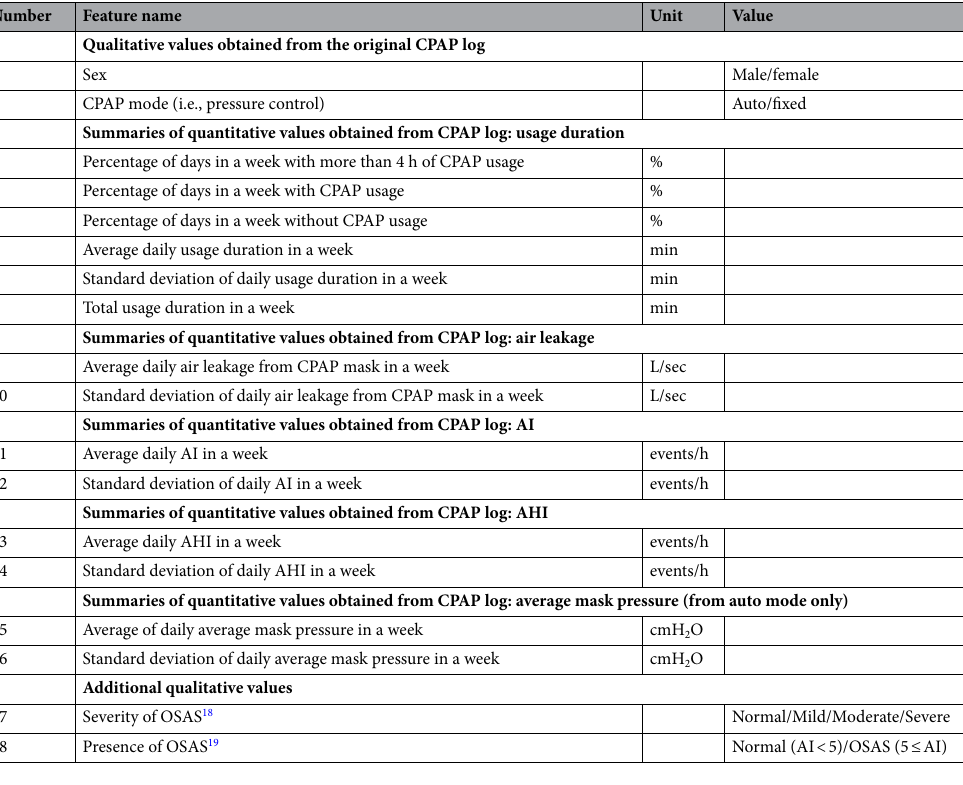
Table 1. List of features obtained from CPAP logs. CPAP continuous positive airway pressure; OSAS obstructive sleep apnea syndrome; AI apnea index; AHI apnea–hypopnea